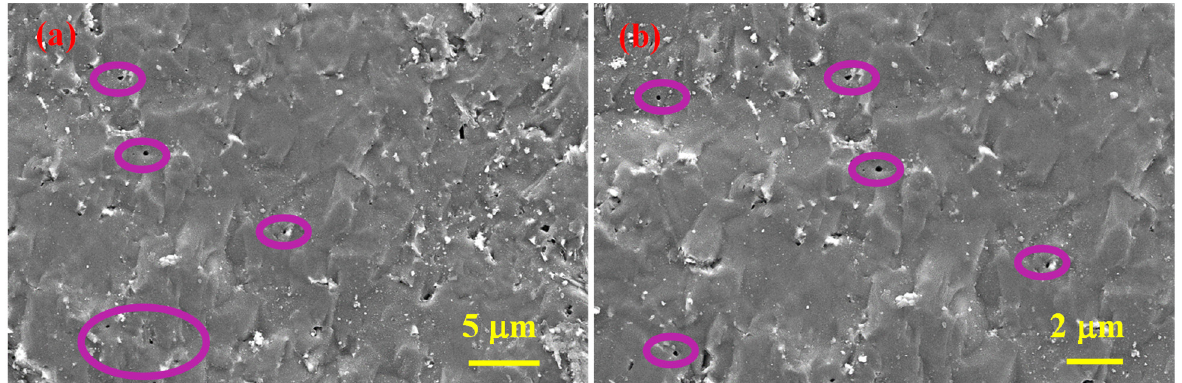
Figure 5. SEM micrographs of the polished surface of SHS-synthesized B 4 C after SPS consolidation at two magnifications ( a , b ), sample 5.